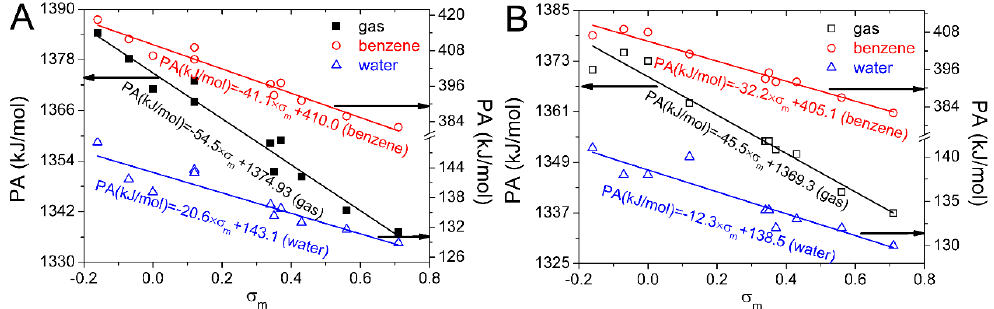
Figure 5. Dependence of PA on Hammett sigma constants for 4′,5,7 -trihydroxyisoflavone ( A ) and 4′,5,7 -trihydroxyisoflavanone ( B ) in gas, benzene, and water phases. The black arrows indicate the corresponding vertical coordinate of the relevant line.